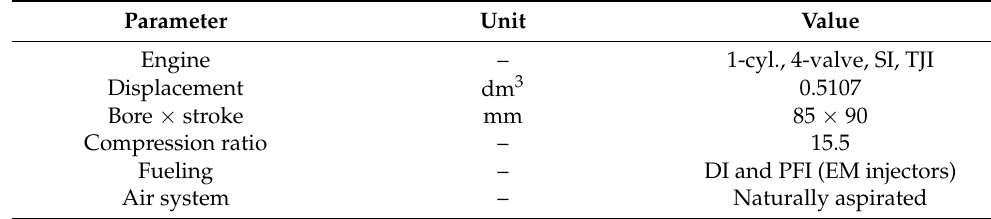
Table 2. Technical data of the single-cylinder test engine used.